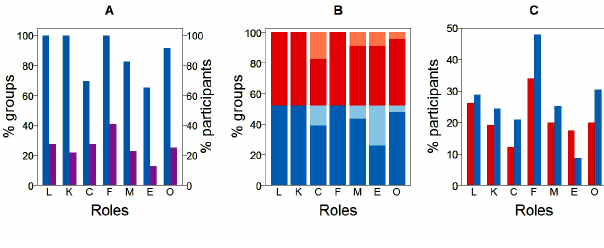
Fig. 4 . Emergent social roles at the group level. (A) Percentage of groups in which the role was present (left blue bars) and percentage of participants that take on each role (right purple bars). (B) Distribution of presence and absence of each role when the data in A are broken down into successful (blue bars in the lower half of the figure) and unsuccessful (red bars in the upper half of the figure) groups. Dark shades mean that the role is present; light shades mean that the role is absent. (C) Frequency of each role in successful (right blue bars) and unsuccessful (left red bars) groups. All groups had at least one leader, knowledge generator, and follower. The rest of the social roles did not emerge in all the groups. The most frequent role was the follower, followed by the knowledge generator, the moralist, the observer, the connector and the enforcer. L = leader, K = knowledge generator, C = connector, F = follower, M = moralist, E = enforcer, O =